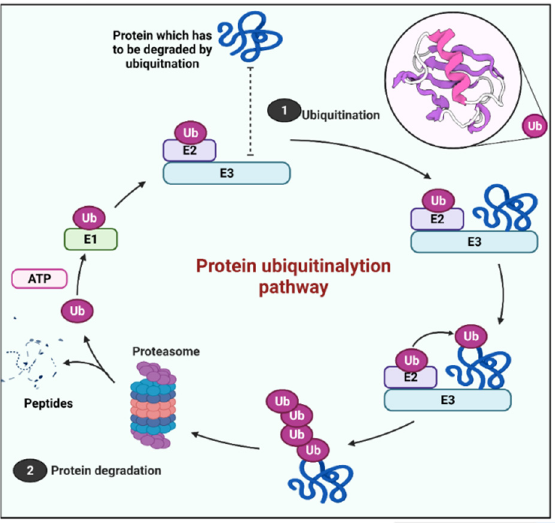
Figure 2. Schematic representation of the protein degradation process by the ubiquitin proteasome system.